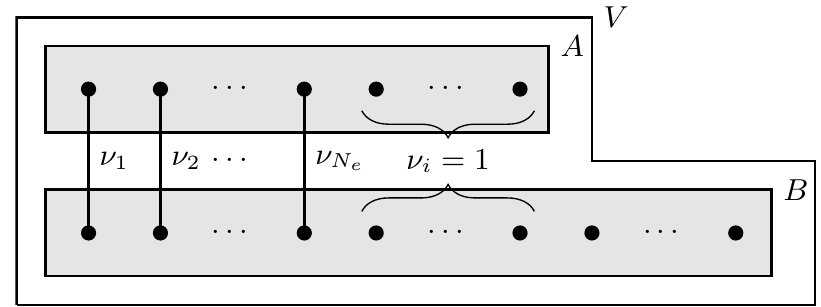
Figure 11 . Entanglement structure of Gaussian states . We illustrate the entanglement structure of an arbitrary squeezed vacuum j J i with subsystems A and B : we can always (cid:12)nd a Darboux frame D V = ( D A ; D B ), such that only pairs of degrees of freedom are entangled across A and B with squeezing parameters (cid:23) i . Every black dot represents a degree of freedom, or equivalently a conjugate variable pair ( ’ i ; (cid:25) i ) appearing as basis vectors in D A or D B , every link represents the entanglement between the two connected degrees of freedom. Note that we take N A (cid:20) N B and (cid:12)nd that only up to N A pairs can be entangled. The remaining N B (cid:0) N A degrees of freedom in subsystem B do not have a partner in subsystem A leading to squeezing parameters (cid:23) i = 0 for i > N A . This is the reason why the maximal number of entangled degrees of freedom is dictated by the smaller of the two